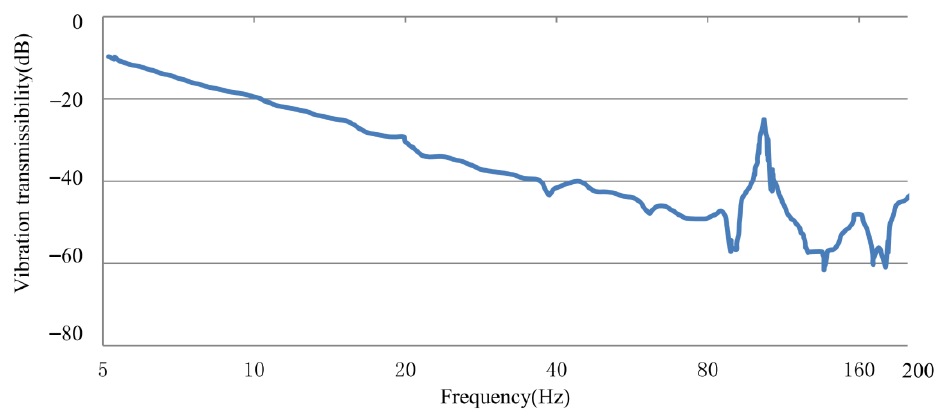
Figure 10. Vibration transmissibility curve of the magnetic antenna damping system.